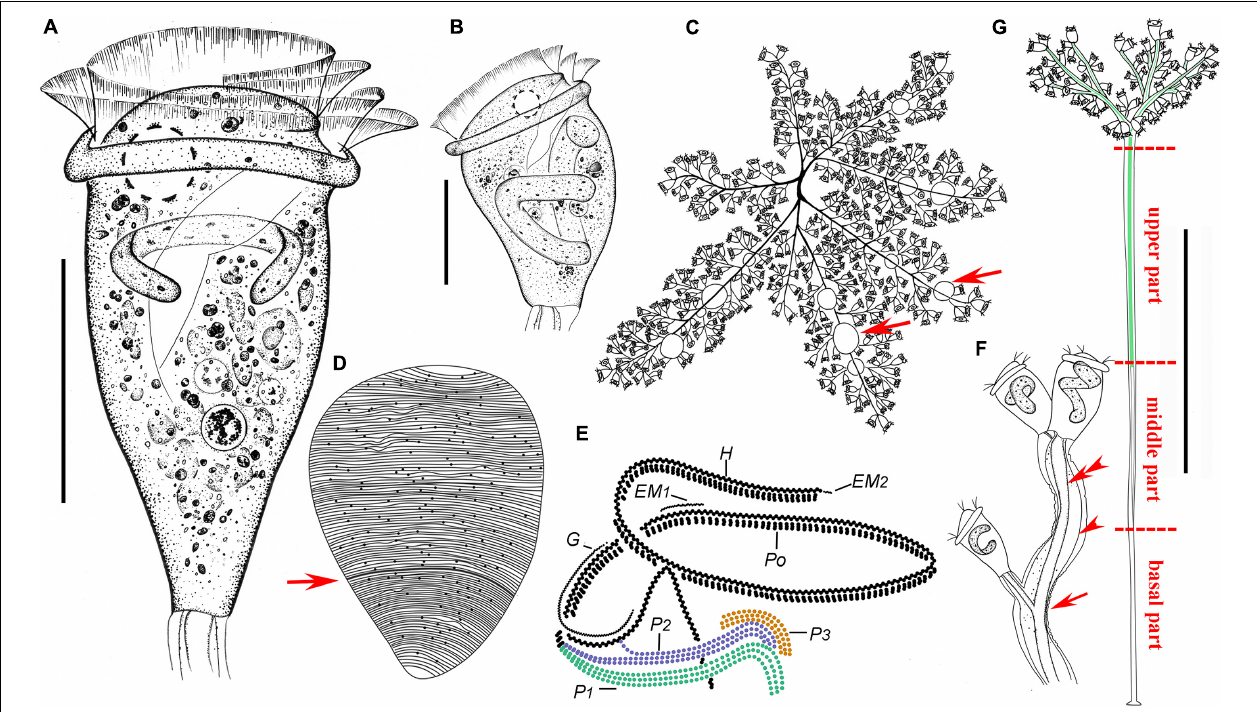
FIGURE 2 | Zoothamnium arbuscula in vivo (A–C,F,G) , after “dry” silver nitrate staining (D) , and after protargol staining (E) . (A,B) Different zooids, showing the shape variation. (C) Apical view of a mature colony; arrows mark the macrozooids. (D) Silverline system; arrow marks the trochal band. (E) Oral ciliature. (F) Branch structure; arrow marks the folds on the surface of the stalk, arrowhead marks the sheath of the spasmoneme, and double arrowhead marks the spasmoneme. (G) A developing colony; the structure in green is the spasmoneme. EM1, 2, epistomial membrane 1, 2; G, germinal kinety; H, haplokinety; Po, polykinety; P1–3, infundibular polykineties 1–3. Bars: 35 µ m in panels (A,B) and 900 µ m in panel (G)